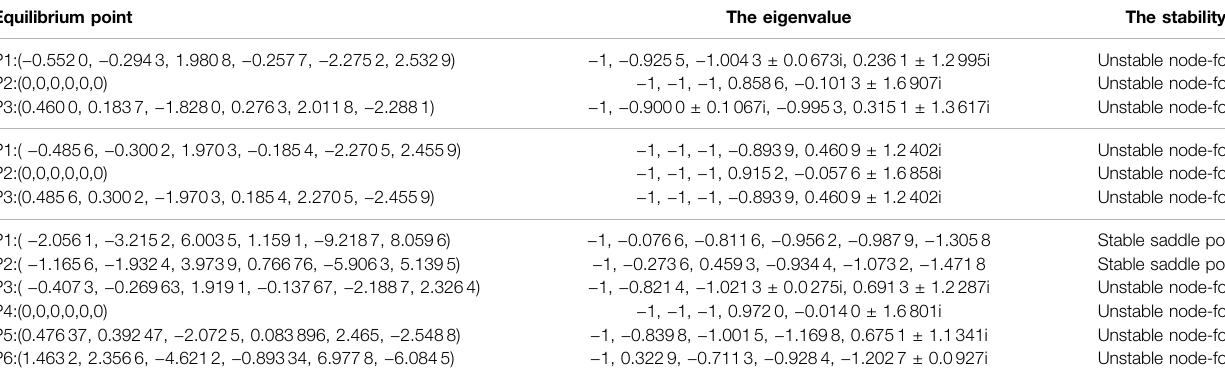
TABLE 1 | The results of equilibrium point analysis when k is taken as − 0.08, 0 and 0.08 respectively Equilibrium point The eigenvalue The